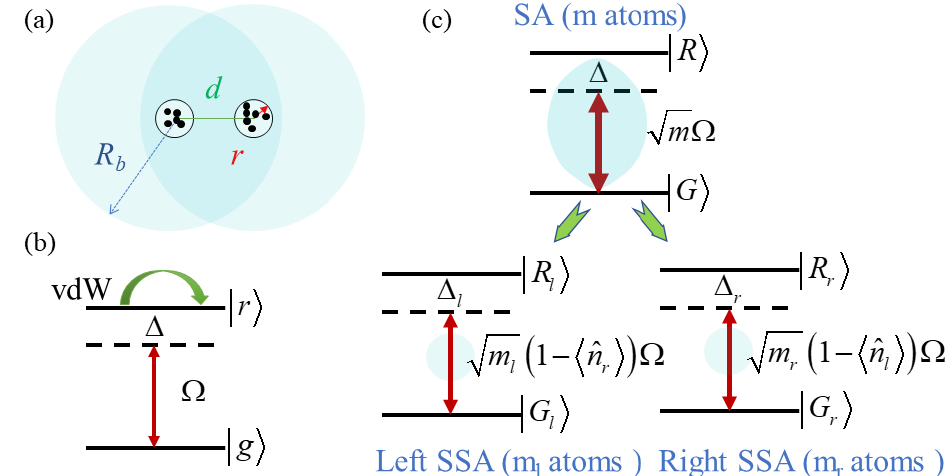
Figure 1. ( a ) The big ( R b ) and the small ( r ) of the concentric circles denote the borders of the blockade region and the optical dipole trap, respectively. d denotes the distance between two optical dipole traps and d > r . The overlap (shading region) of two big circles represents the blockade region for all atoms randomly distributed in two optical dipole traps by setting geometrical parameters to the appropriate values. ( b ) Level structure for a Rydberg atom. Two atoms with simultaneous Rydberg excitations interact via van der Waals (vdW) potential. ( c ) Level structures for a SA and its two SSAs: due to the blockade effect, a big SA containing m atoms can be divided into two little ones, i.e., the left SSA and the right one, representing the sub-ensemble of m l atoms trapped in the left trap and the sub-ensemble of m r atoms trapped in the right one,